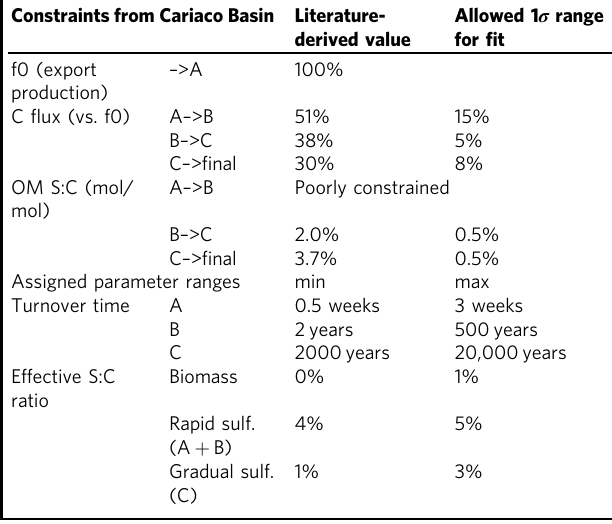
Table 1 Parameters used in organic carbon cycle model Constraints from Cariaco Basin Literature-